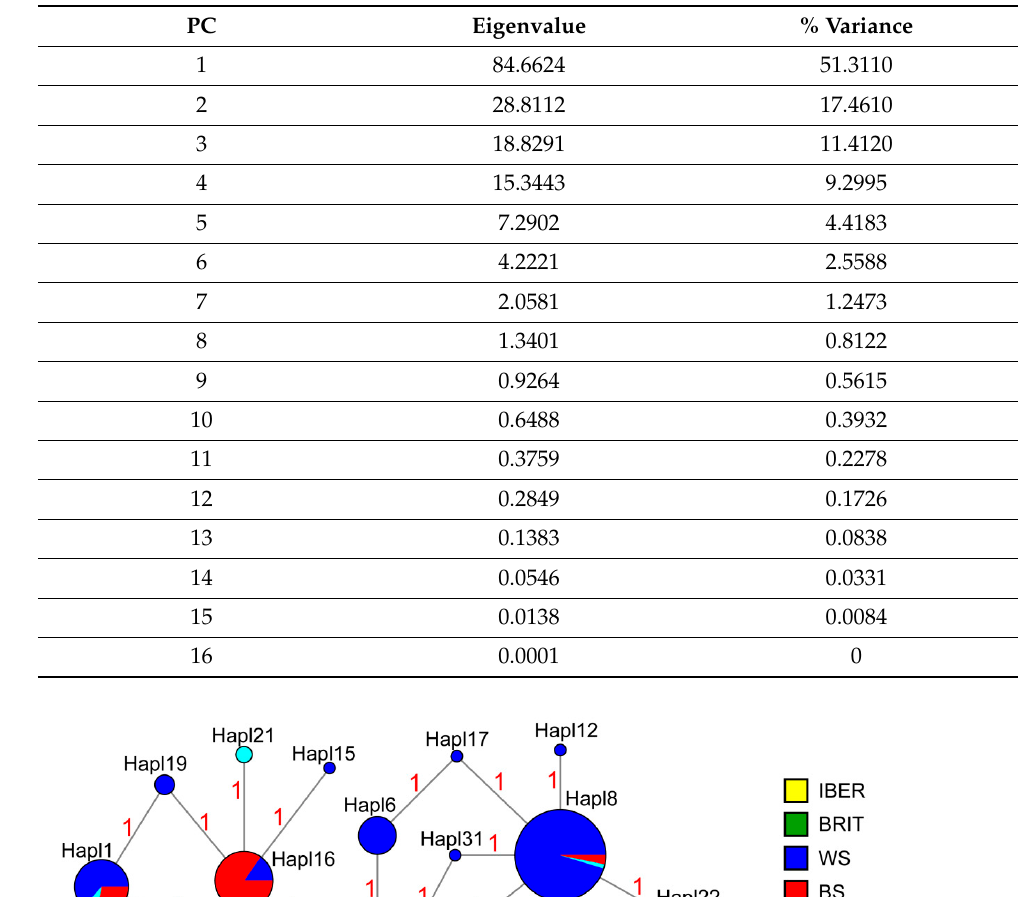
Table 5. Results of the principal component analysis (PCA) of the haplotype frequencies matrix in Margaritifera margaritifera populations under the factor “Basin”: eigenvalues and percentages of contribution to the overall variability. PC Eigenvalue